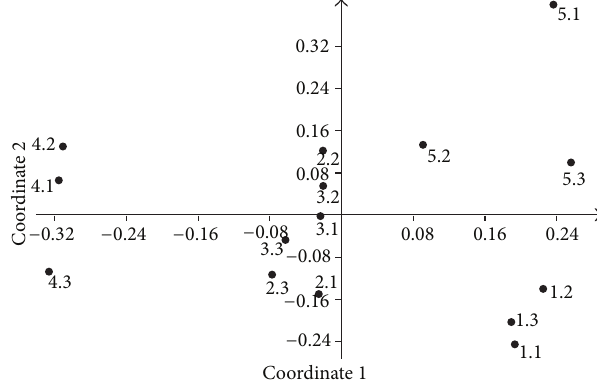
Figure 3: NMDS plot obtained from T-RFLP data